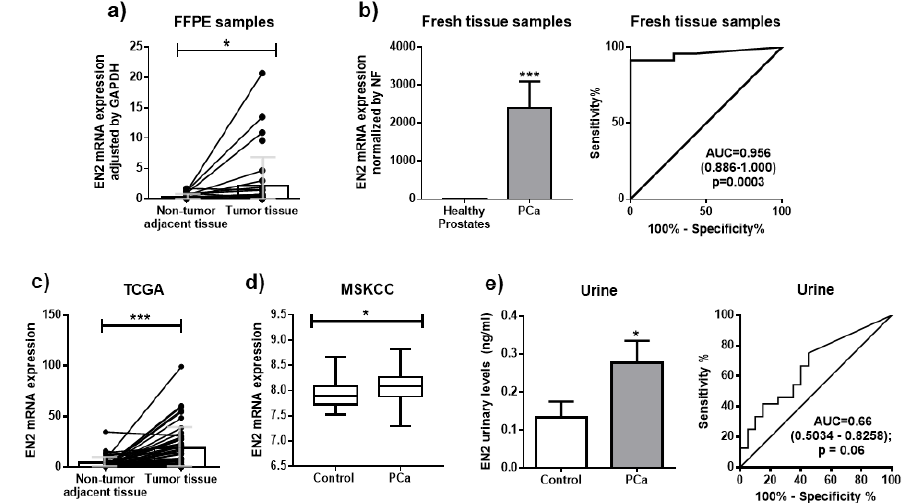
Figure 1. EN2 is overexpressed in prostate tissue and urine from PCa patients. ( a ) Paired analysis of EN2 mRNA expression levels in PCa tissue and matched adjacent non-tumor tissue from 33 Formalin-fixed paraffin-embedded (FFPE) prostatectomy samples. Absolute mRNA levels were determined by qPCR and adjusted by GAPDH housekeeping gene. ( b ) mRNA expression levels of EN2 in a battery of 23 PCa samples and compared to the expression levels found in seven normal prostates. Absolute mRNA levels were determined by qPCR and adjusted by normalization factor (NF). Receiver operating characteristic (ROC) curve analysis to determine the accuracy of EN2 to discriminate between tumor and healthy tissue. ( c ) Analysis of EN2 mRNA expression levels in 52 PCa samples and 52 non-tumor adjacent samples from TGCA data set. ( d ) Analysis of EN2 mRNA expression levels in 29 non-tumor tissue and 150 PCa tissues from the MSKCC data set. ( e ) Evaluation of EN2 levels as a non-invasive PCa diagnostic marker. EN2 urinary levels in 24 PCa patients (filled bars) compared to 20 controls (healthy and negative biopsy patients; open bars), determined by ELISA assay, without prostate massage (left panel). ROC curve analysis to determine the accuracy of EN2 to discriminate between tumor and healthy patients (right panel). Data represent mean ± SEM. * p ≤ 0.05, *** p < 0.001 indicate values that significantly differ between groups.